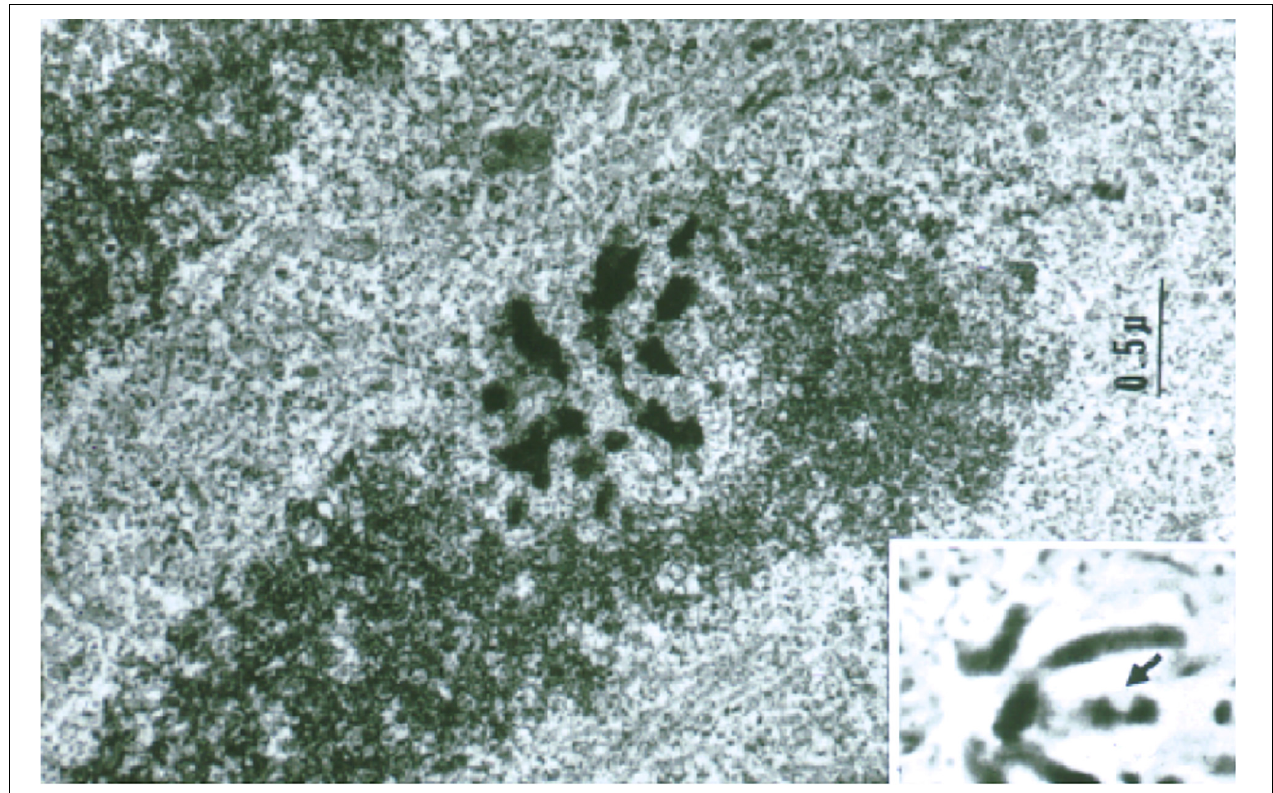
FIGURE 6 | Transmission electron microscope (TEM) image of a laser-irradiated chromosome observed in a live mitotic cell by phase contrast (inset) and fixed, sectioned, and viewed by transmission electron microscopy. Note the phase-lightening of the laser lesion in the inset, and the matching region of the same chromosome in the TEM image. The 0.5–1 µ m damage was confined to the laser irradiation spot (Rattner and Berns,